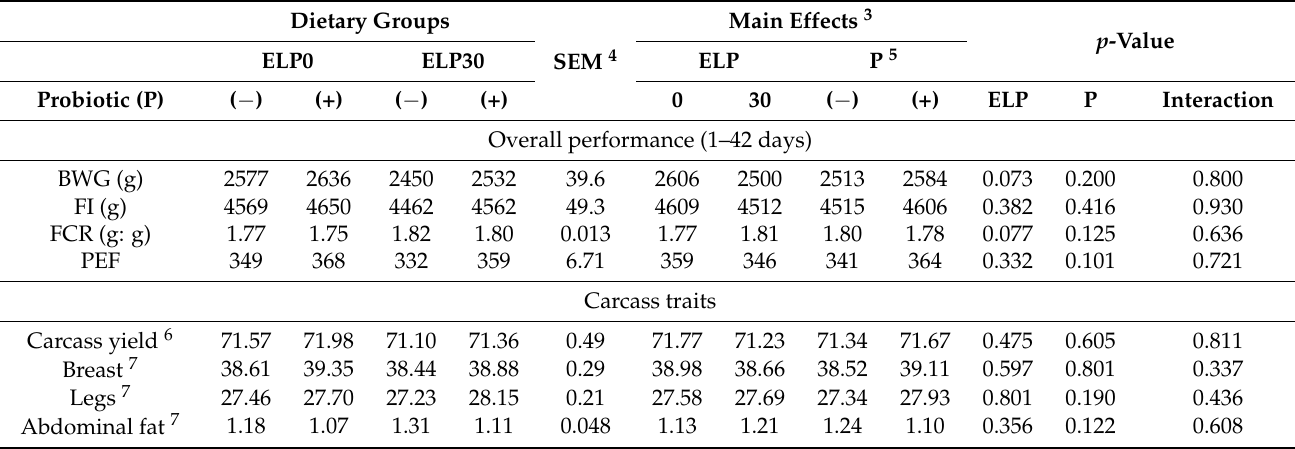
Table 3. Productive performance 1 and carcass traits 2 of